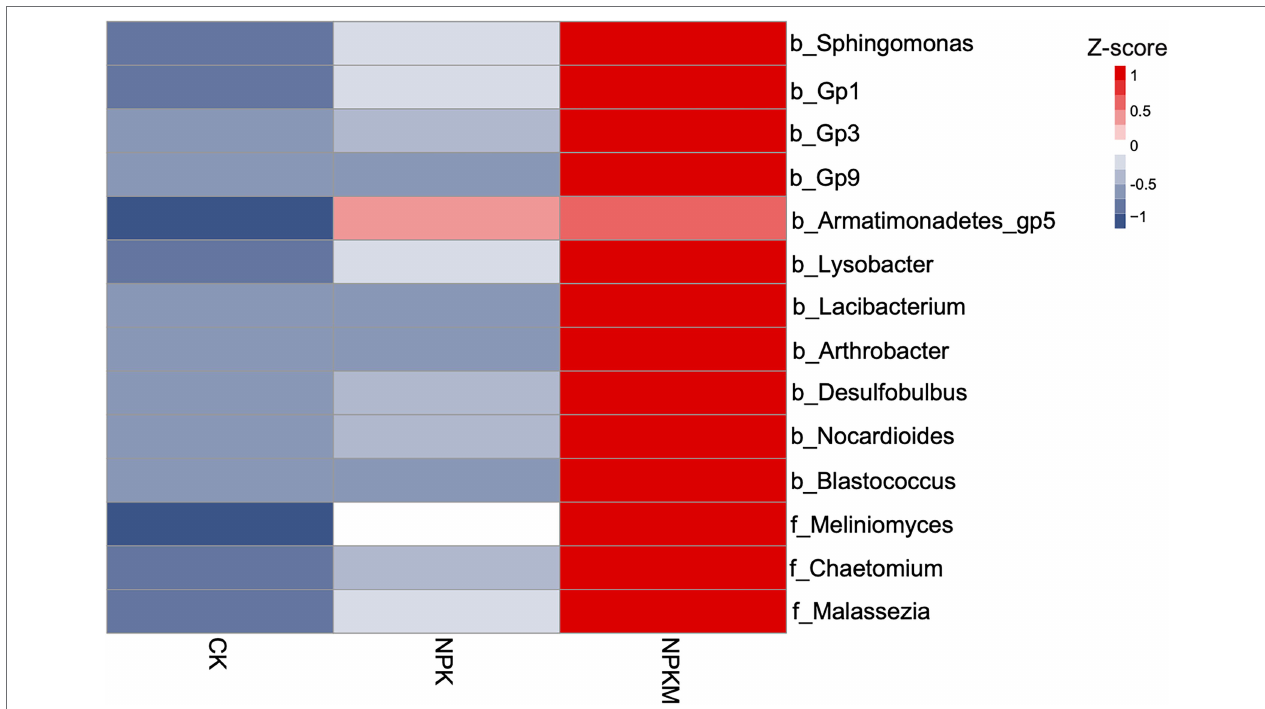
FIGURE 5 | Heat map of relative abundances of genera of bacteria and fungi with positive correlations to rice yield. Relative abundances were Z -score normalized. Genus-level bacteria names begin with “b”, and genus-level fungi names begin with